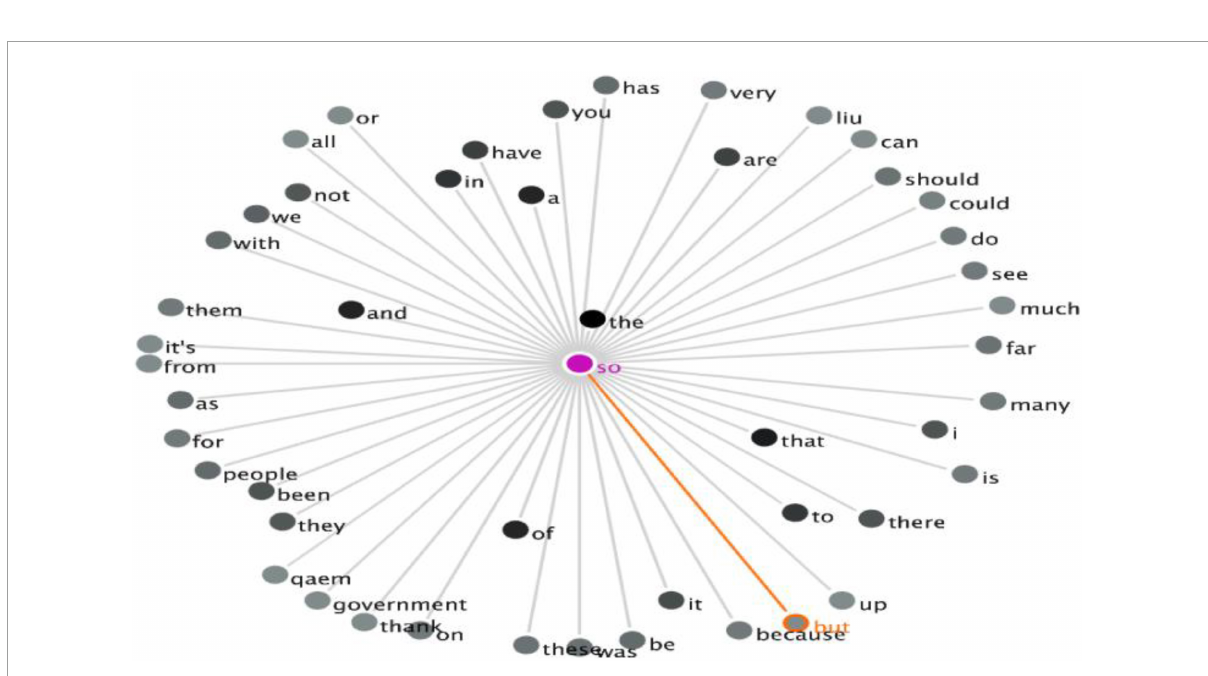
FIGURE2 The GraphColl of the co-occurrence of “so but” in the Chinese